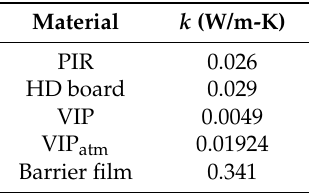
Table 1. Materials and thermal